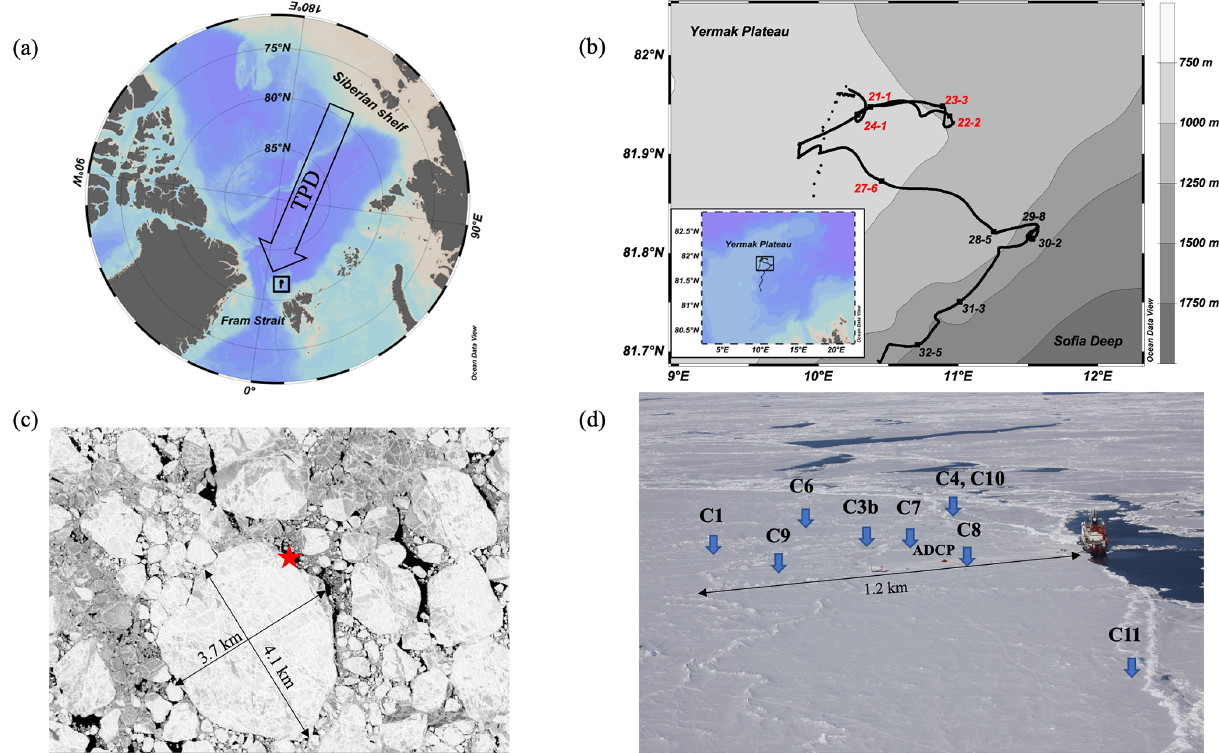
Figure 1. (a) The location of the PS106.1 study area north of Svalbard (black rectangle). The arrow shows the general direction of the Transpolar Drift (TPD). (b) The drift track of the ice camp between 4 and 15 June 2017 overlaid on the bathymetry of the region. In red are the stations located over the Yermak Plateau (Region 1), and in black are those over the Yermak Plateau eastern flanks (Region 2). (c) Satellite image of the ice floe serving as our drifting platform. The star shows the location of the RV Polarstern . (d) Positions of the ice coring stations. Note that C4 and C10 were taken at the same location but on different dates. Photo credit (Fig. 1d): Giulia